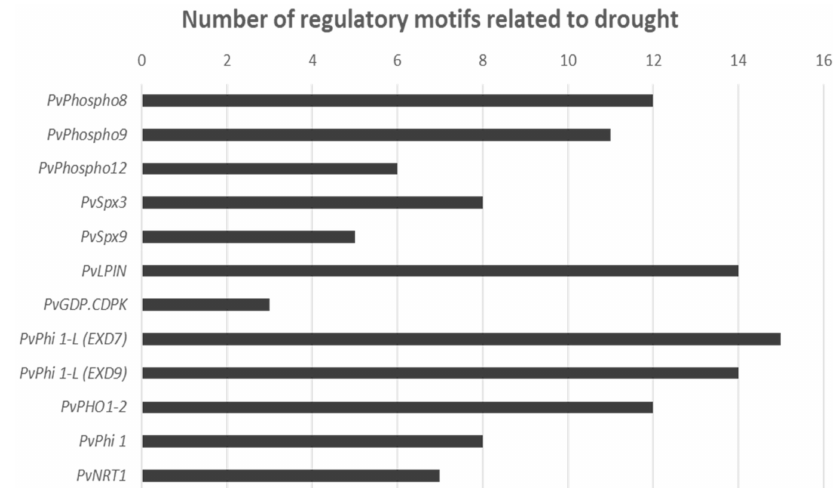
Figure 5. Representation of the number of regulatory motifs related to drought in the promoter sequences of the phosphate starvation related DEGs. Promoter sequences of the genes were retrieved from Phytozome (https: // phytozome.jgi.doe.gov / pz / portal.html#), and 1500 bp upstream the ATG of